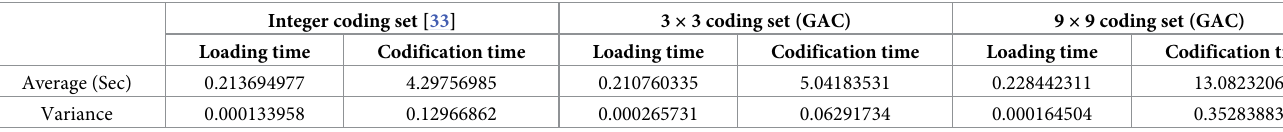
Table 8. Average run time for loading and encoding 303 query